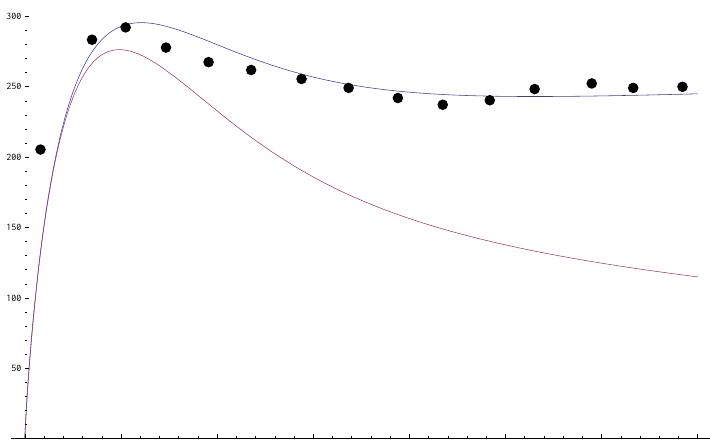
Figure 3. Rotation curve for galaxy NGC